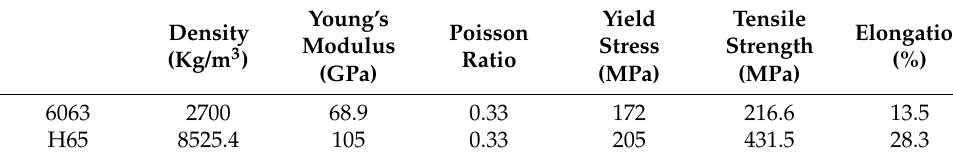
Table 3. Main mechanical characteristics of materials at room temperature.